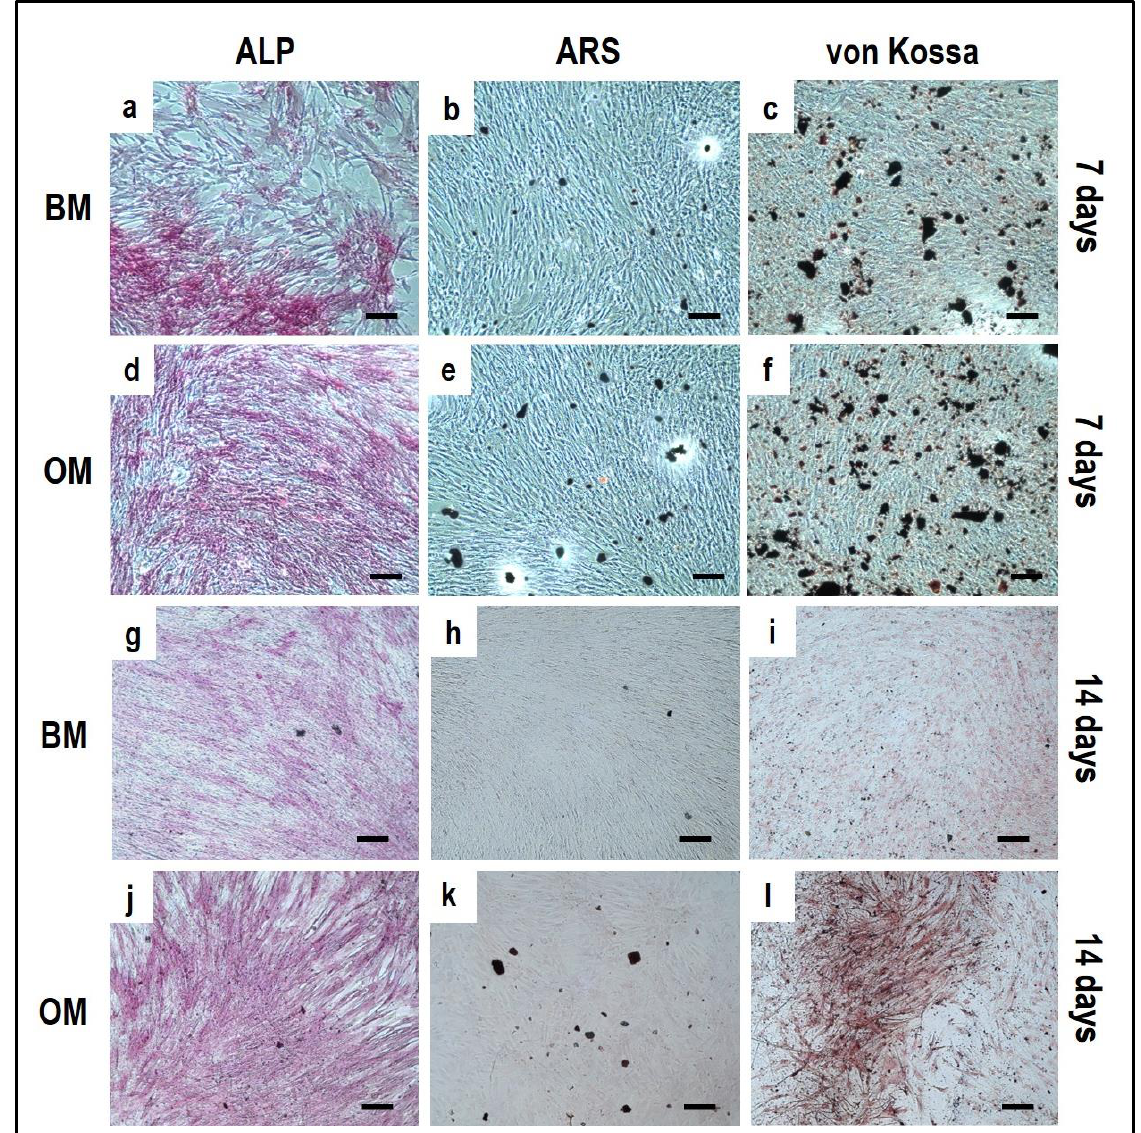
Figure 5. Microphotographs of alkaline phosphatase (ALP) ( a , d , g , j ), Alizarin Red S (ARS) ( b , e , h , k ) and von Kossa ( c , f , i , l ) stainings of OBs control culture at 7 and 14 days. ( a – c ): basal medium at 7 days, ( d – f ): osteogenic medium at 7 days, ( g – i ): basal medium at 14 days, ( j – l ): osteogenic medium at 14 days. Scale bar: 100 µm.